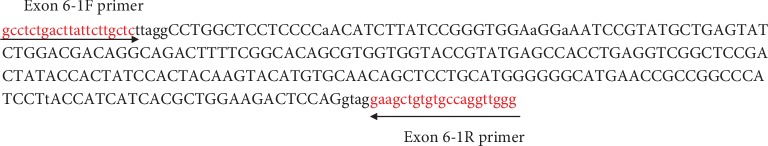
Nucleotide sequence of the amplified PCR product (273 bp) representing exon 6 of rat p53 gene in the control group.